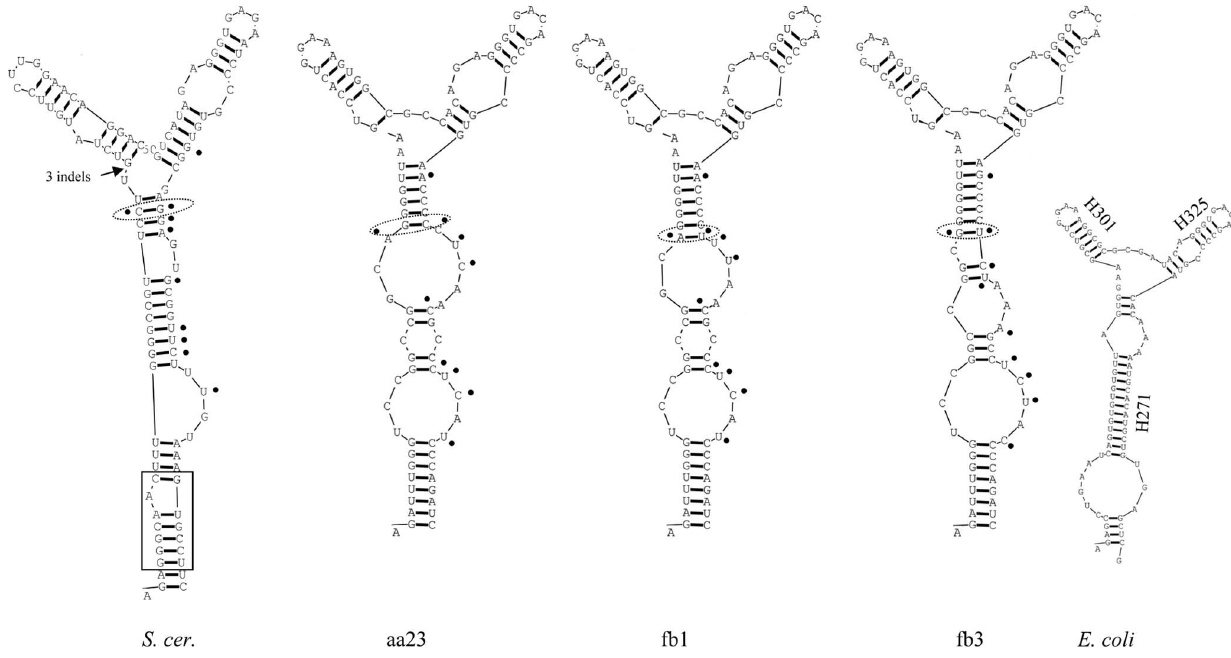
Figure 2. Predicted secondary structures of D1 hairpin-stem loops. Only examples of the M. andauensis (aa23) and M. fructicola (fb1 and fb3) clones are shown. The variable sites and their equivalents in the S. cerevisiae molecule ( S. cer. ) are marked with dots. The boxed region is the helical segment missing in the cloned Metschnikowia sequences. For E. coli helix nomenclature see http://www.rna.icmb.utexas.edu/.